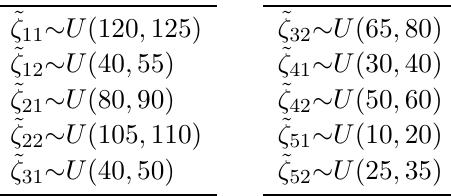
Table 1: Uniform distributions for the random task